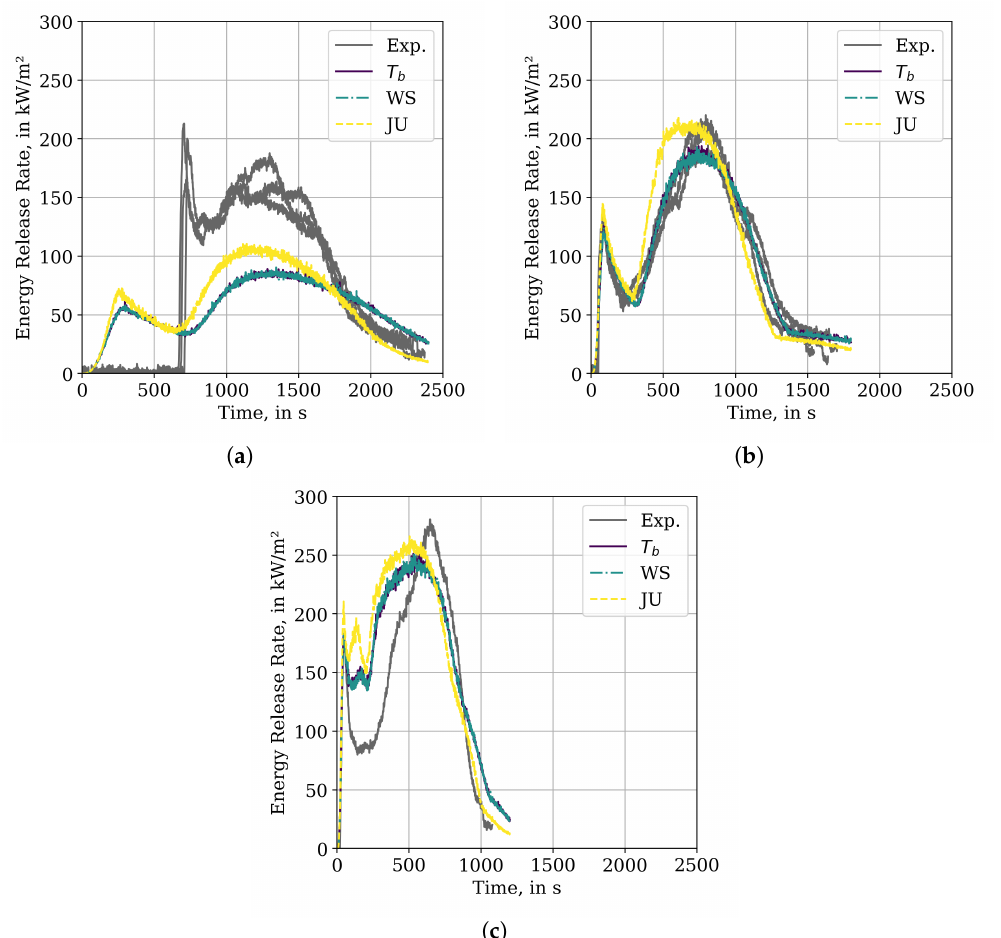
Figure A13. Comparison between energy release rates of Cone Calorimeter simulation of the best parameter set of IMP T b . T b : JURECA, Linux, FDS 6.5.3; WS: Workstation, Windows 10, FDS 6.5.3; JU: JURECA, Linux, FDS 6.7.0. ( a ) Experimental condition: 25 kW/m 2 . ( b ) Experimental condition: 50 kW/m 2 . ( c ) Experimental condition: 75 kW/m 2 .